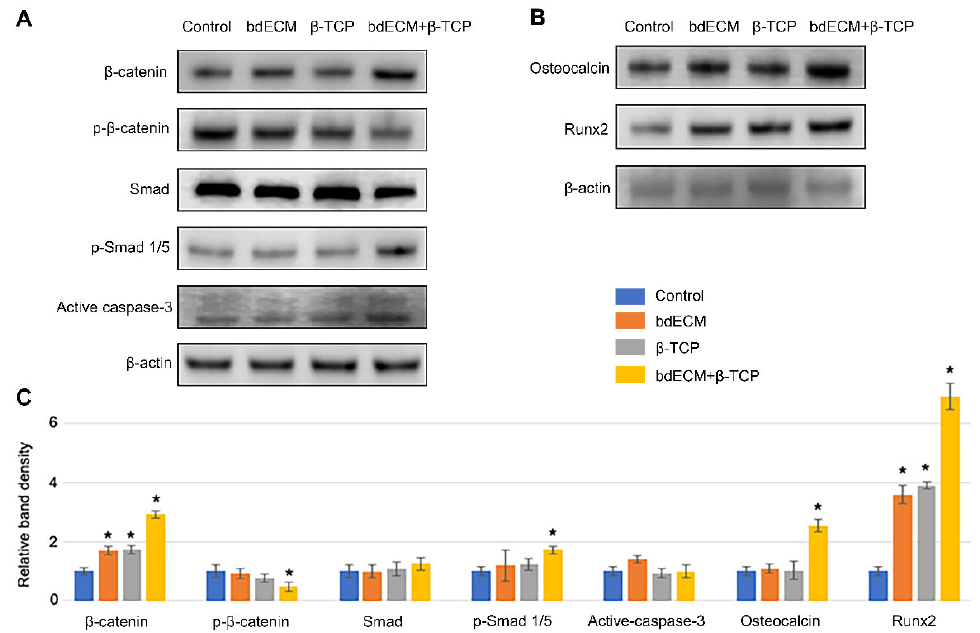
Figure 2. Western blotting analysis for intracellular signaling pathway and osteogenic differentia ‐ tion. ( A ). Protein derived from pre ‐ osteoblast cell line MG63 was blotted for alteration of signaling pathway in Day 2. β‐ catenin and phospho ‐β‐ catenin were measured to confirm canonical Wnt sig ‐ naling pathway. Smad and phospho ‐ Smad1/5 were measured to confirm BMP2 signaling pathway. Active caspase3 was measure for cytotoxicity and showed no difference; ( B ). Protein derived from pre ‐ osteoblast cell line MG63 was blotted for bone formation marker osteocalcin and Runx2 in Day 5; ( C ). Band densities were measured at least three times for statistical analysis and all data were expressed as mean ± standard deviation. Asterisk indicates significant difference ( p < 0.05) compared